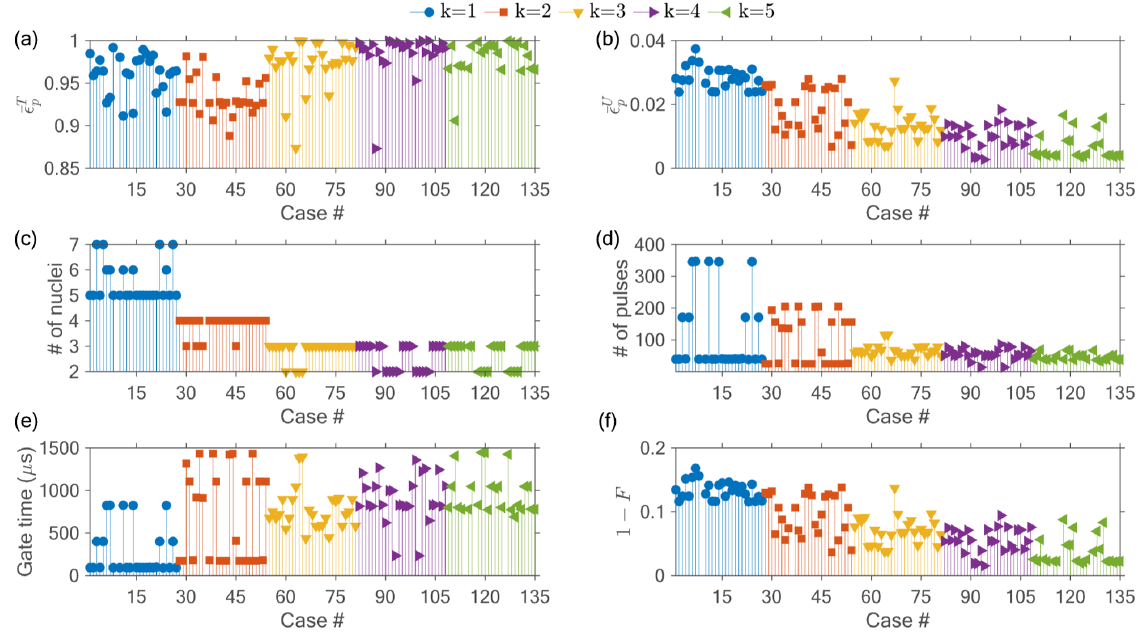
FIG. 8. Performance of 135 distinct multipartite gates in a 27 nuclear spin register using the CPMG sequence. Each gate is labeled by a case number, which is equal to j þ ð k − 1 Þ · 27 , where j ∈ ½ 1 ; 27 (cid:2) labels nuclei and k ∈ ½ 1 ; 5 (cid:2) labels resonances. Each gate is generated by a different driving sequence determined by the CPMG unit time and number of iterations, with the former tuned close to the k th resonance of nucleus j . (a) Mean value of target nuclei one-tangles for each gate; each target one-tangle contributing to the mean is scaled by the maximum value of 2 = 9 . (b) Mean value of unwanted nuclei one-tangles; each unwanted one-tangle contributing to the mean is scaled by the maximum value of 2 = 9 . (c) Number of target spins participating in each multipartite gate. (d) Number of iterations and (e) gate time of each multipartite gate. (f) Gate error due to residual entanglement with unwanted nuclear